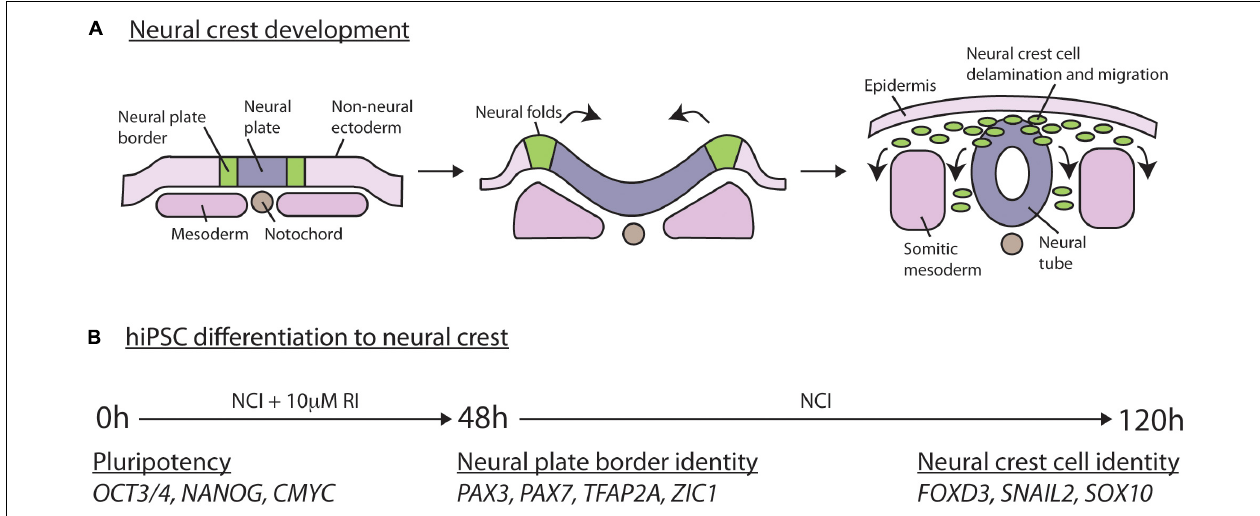
FIGURE 2 | Neural crest induction in vivo and in human induced pluripotent stem cells. (A) In vivo neural crest induction occurs at the border (green) between the neural plate (blue) and the non-neural ectoderm (light pink). As neurulation progresses the neural folds begin to approximate and neural crest delaminate from the epithelium and begin migration. (B) In vitro neural crest induction in hiPSCs following the protocol from Leung et al., 2016. hiPSCs are plated on Matrigel and treated for 48 h in neural crest induction (NCI) media plus Rock inhibitor (RI). This is followed by incubation in neural crest induction media without RI until 120 h of culture. At the start, pluripotency markers ( OCT3/4, NANOG, and CMYC ) are expressed. By 2 days of culture, neural border markers are expressed ( PAX3, PAX7, TFAP2A, ZIC1 ). By 5 days of culture, cells express markers of neural crest identity ( FOXD3, SNAIL2, SOX10 ).